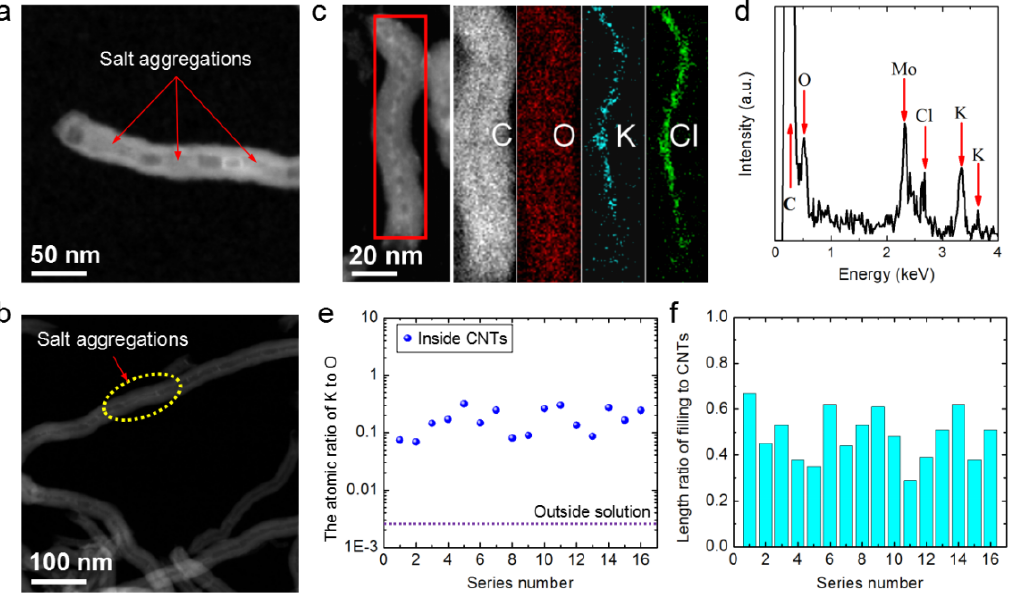
Figure 5. ( a ) A high-angle annular dark field scanning transmission electron microscopy (HAADF-STEM) image of a KCl aggregation at the mouth of a long CNT. ( b ) An HAADF-STEM image showing the mid-section of a long CNT. ( c ) An HAADF-STEM image of a KCl aggregation inside an ultra-short CNT and the corresponding EDS mappings. ( d ) EDS results for the aggregation in (c) (the Mo signal comes from the Mo sample grid). ( e ) K/O atomic ratios (blue points) of 16 aggregations inside 16 random ultra-short CNTs and the K/O ratios of the outside solution (dashed line). ( f ) Filling length/total length ratios for these 16 ultra-short CNTs.